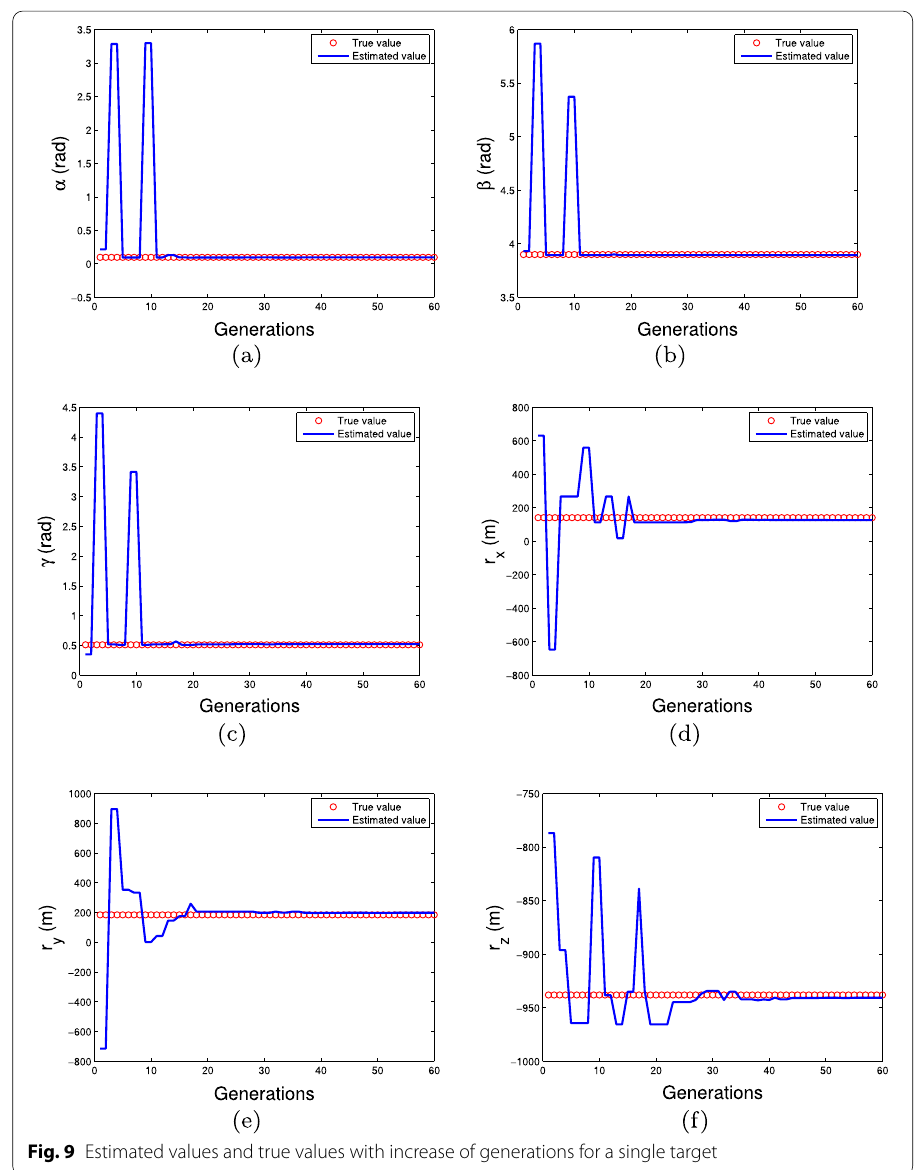
Fig. 9 Estimated values and true values with increase of generations for a single target